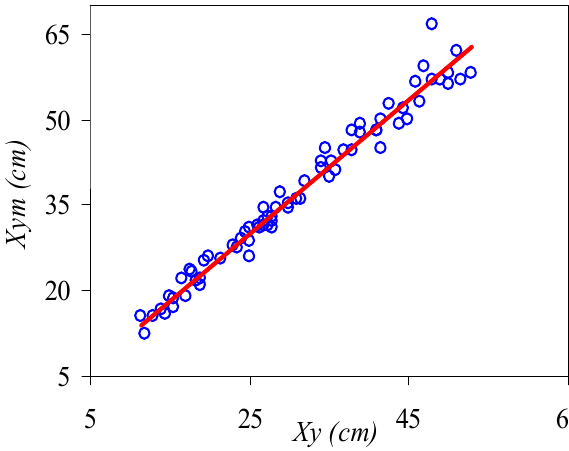
) for all experimental cases. ym